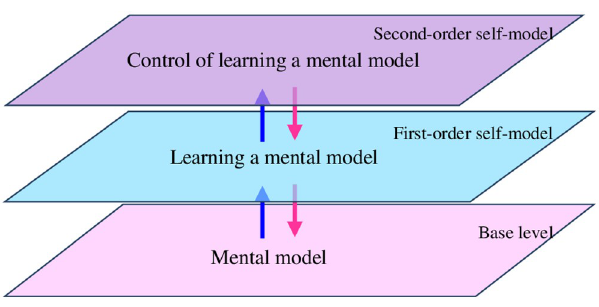
Fig 1. Overview of the introduced second-order adaptive network architecture.